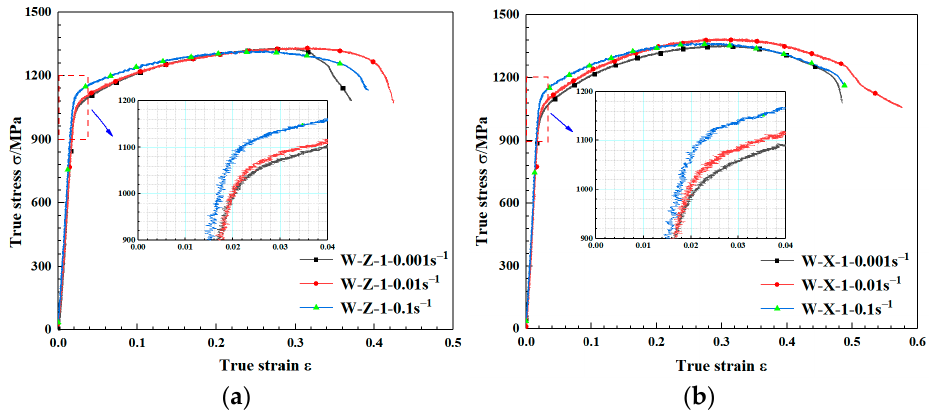
Figure 10. Stress–strain curves for the same specimen at different strain rates. ( a ) Group Z specimens (deposition direction). ( b ) Group X specimens (scanning direction).